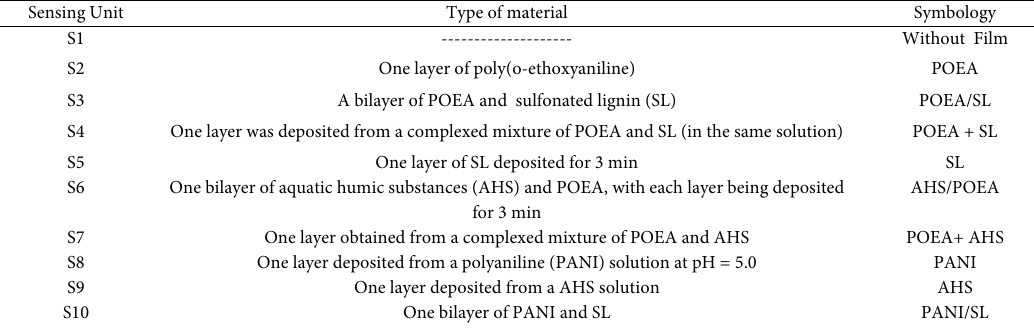
Table 1. Sensing units in the sensor array to analyze